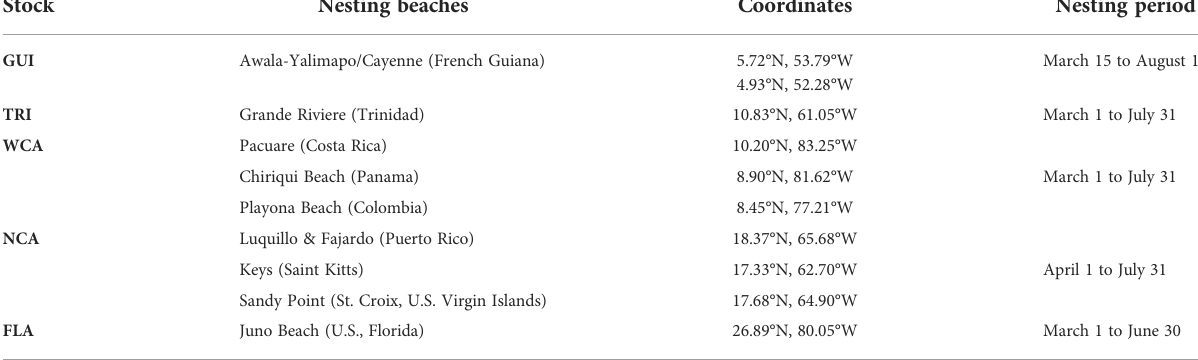
TABLE 1 Nesting sites used for dispersal